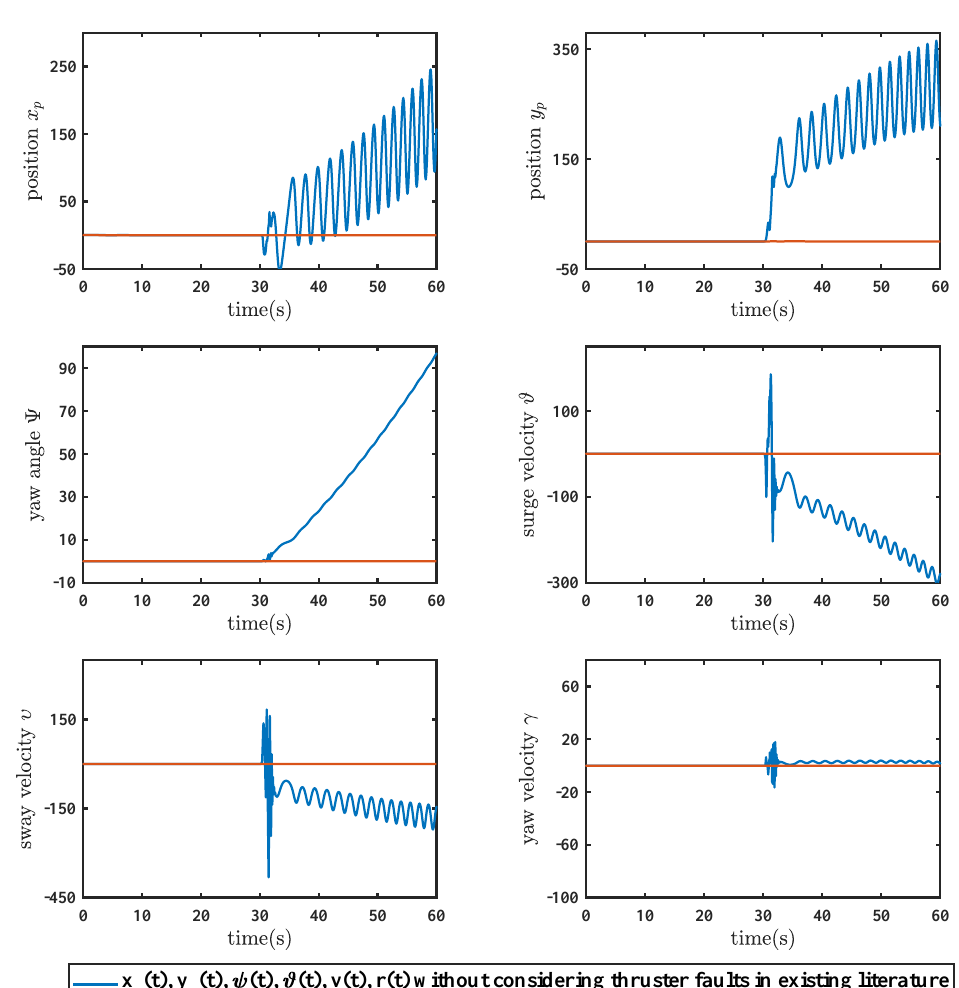
Figure 4. Comparison of system responses x ( t ) with a normal controller and using the techniques developed in this